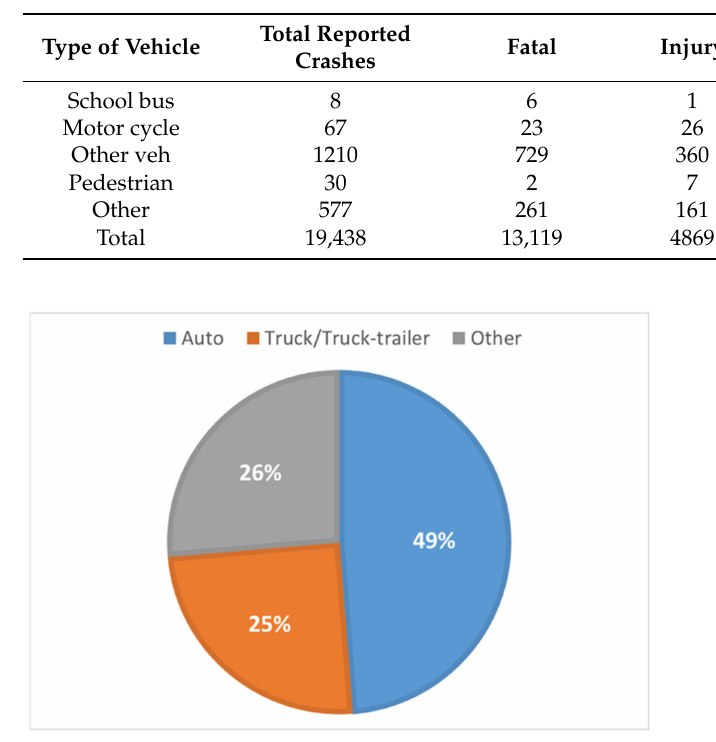
Figure 1. Accidents by vehicle type at